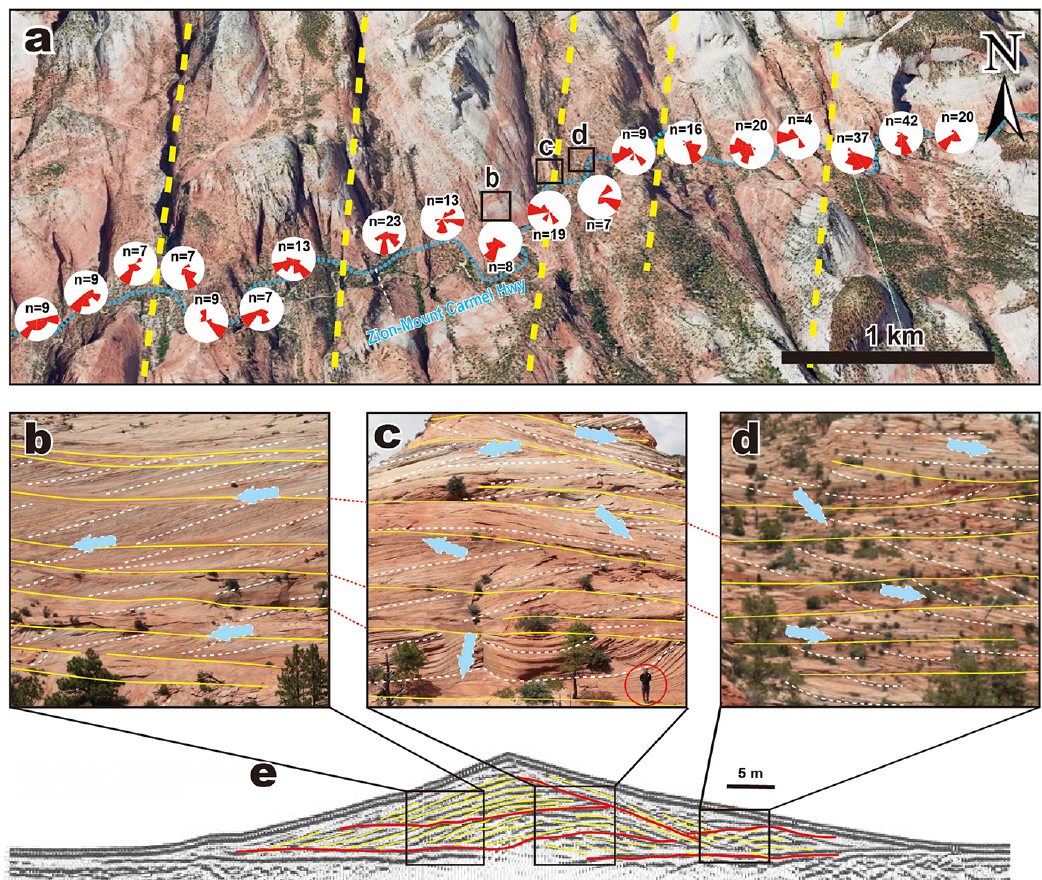
Figure 2. Spatial pattern of dune slip-face azimuths and outcrop photographs of the Navajo Sandstone in the Zion National Park, and comparison with the internal structure of a modern longitudinal dune. (a) Spatial distribution of palaeowind data along the Zion–Mount Carmel Highway. Yellow dotted lines are the inferred locations of the central crests of longitudinal dunes, which are spaced at horizontal intervals of ∼ 1km (© Google Earth 2016). (b–d) Outcrop photographs of cross-stratification in the Navajo Sandstone. Yellow solid lines and white dashed lines indicate the bounding surfaces of aeolian dune strata and slip-face cross-stratifications, respectively. All photographs were taken facing north. Red circle in (c) indicates a person for scale (ca. 1.7m tall). (e) Ground-penetrating radar (GPR) profiles showing the internal structure of a modern longitudinal dune (Bristow et al., 2000). Yellow and red traces indicate slip faces and unconformities,